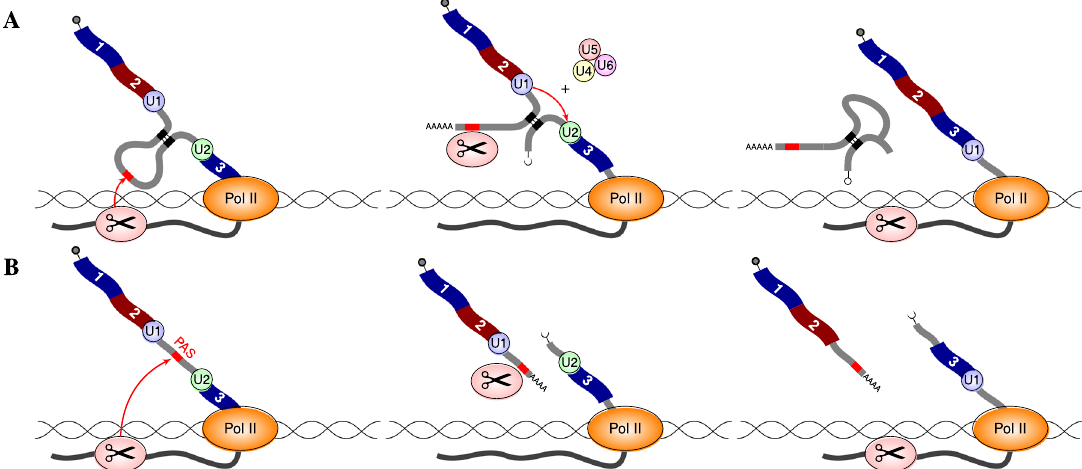
Fig. 7 RNA folding and splicing could mediate co-transcriptional suppression of premature cleavage and polyadenylation (a hypothesis). A The cleavage and polyadenylation of a structured pre-mRNA is rescued by the co-transcriptional splicing of the intron, while RNA structure stabilizes the molecule through intramolecular base pairings. B In the absence of RNA structure, such a rescue would not happen when splicing has a delay relative to cleavage and polyadenylation. Switching between ( A ) and ( B ) depends on the rates of splicing, folding, and RNA Pol II